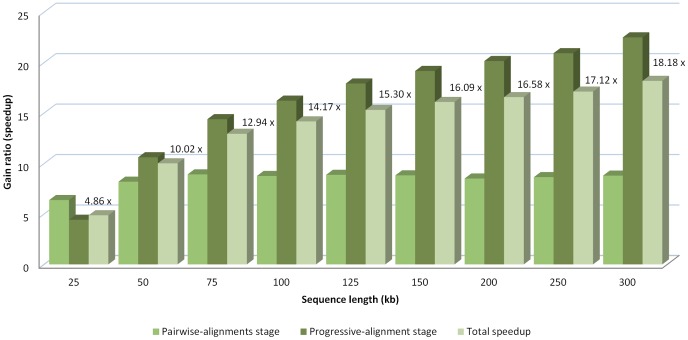
Speedup of the MC64-ClustalWP2 against Clustal W 1.83.The speedup is shown both for each relevant stage and for the full execution when aligning sets of ten randomly-generated sequences of different sizes.